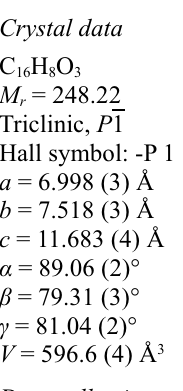
Figure 1 The molecular structure of the title compound, with displacement ellipsoids drawn at the 30% probability level.